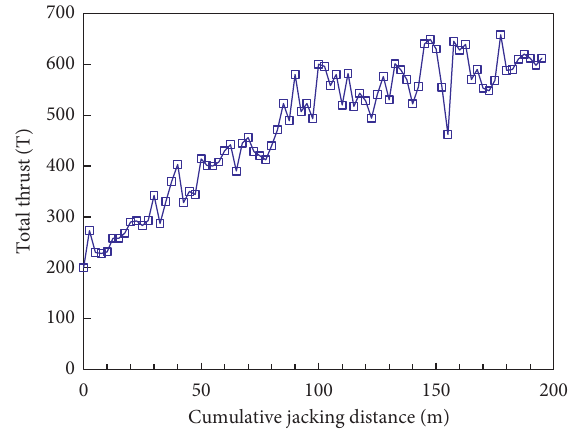
Figure 5: Curve of total thrust with mileage.